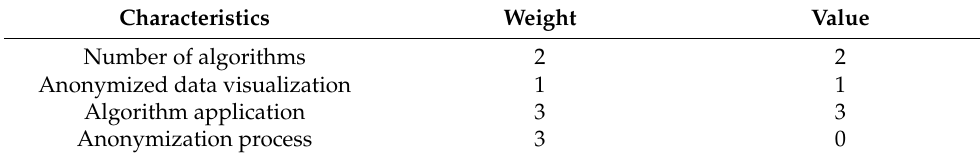
Table 2. Functionality Category—ARX Data Anonymization Tool.